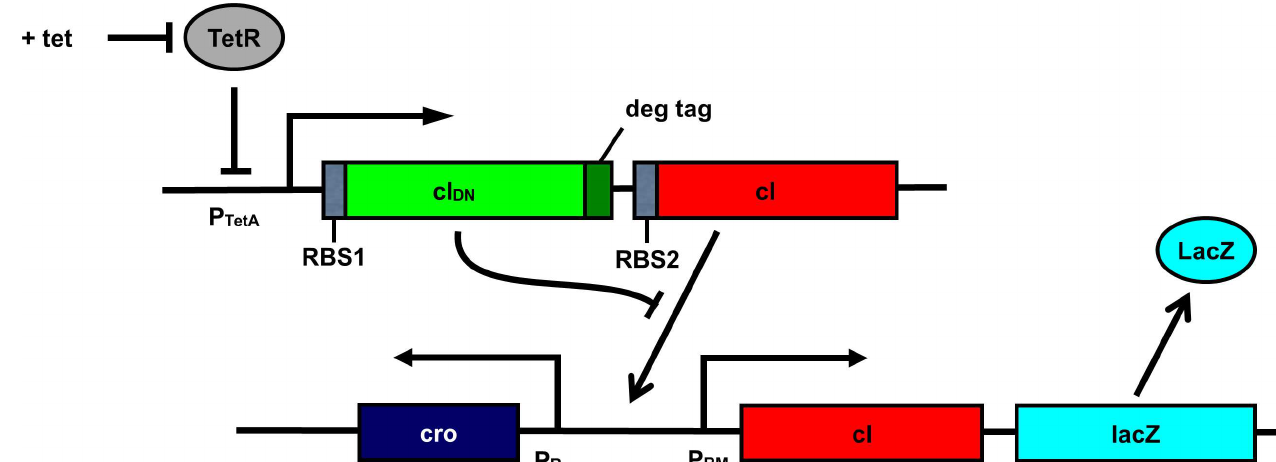
Fig 5. The design of the counter circuit. The two componentsof the design are the falling edge pulse detector circuit shown in Fig 1 and the lambdamemory